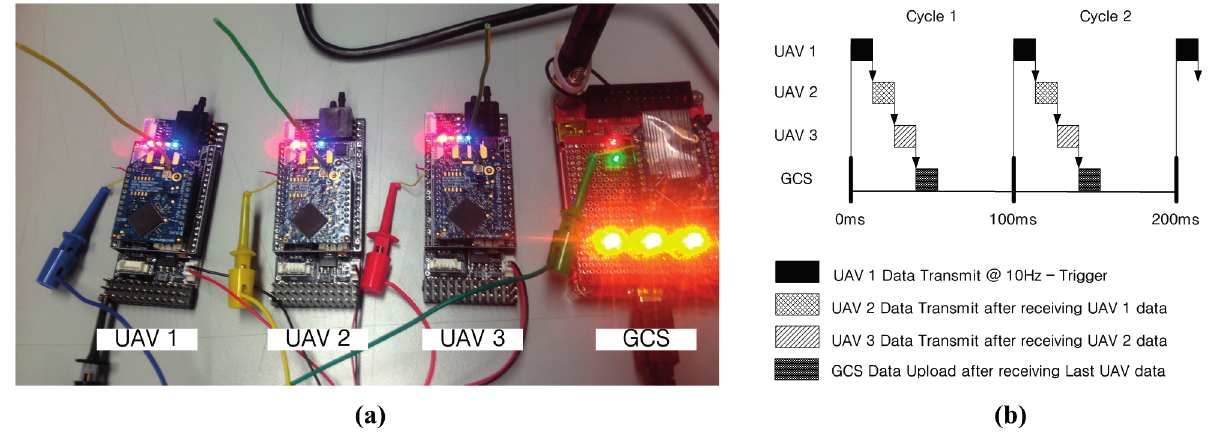
Figure 6. ZigBee communication delay between UAV1 and UAV2.